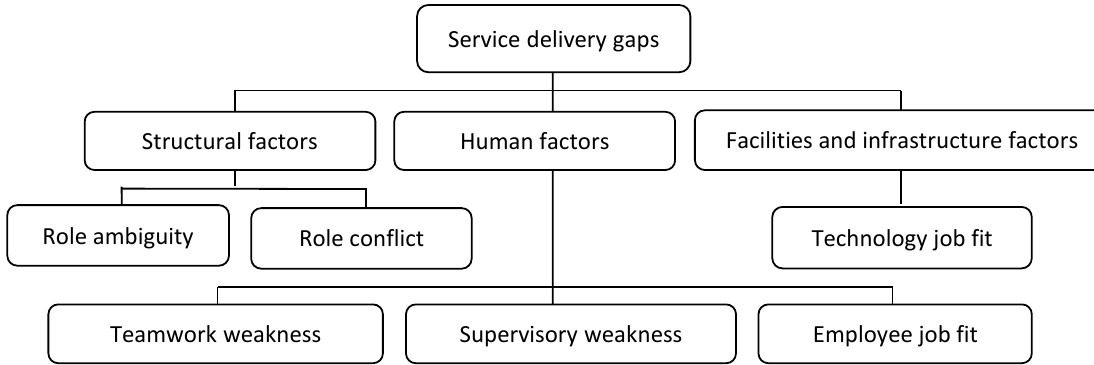
Figure 1. Theoretical service delivery gaps